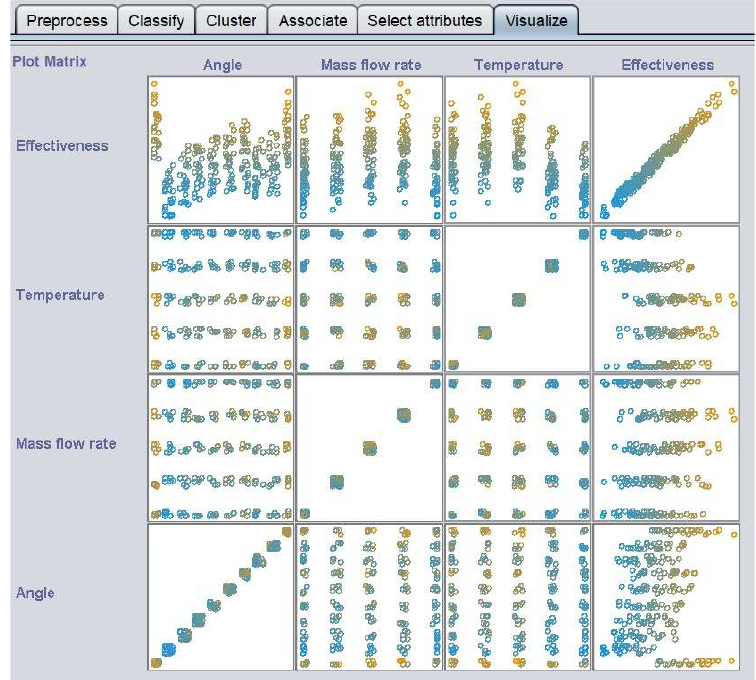
Figure 3. Scatter plot of parameters and responses. Table 3. Determination of the